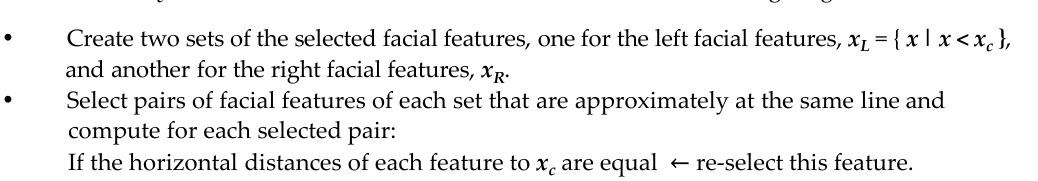
Figure 4. Feature re-selection algorithm for User Detection.